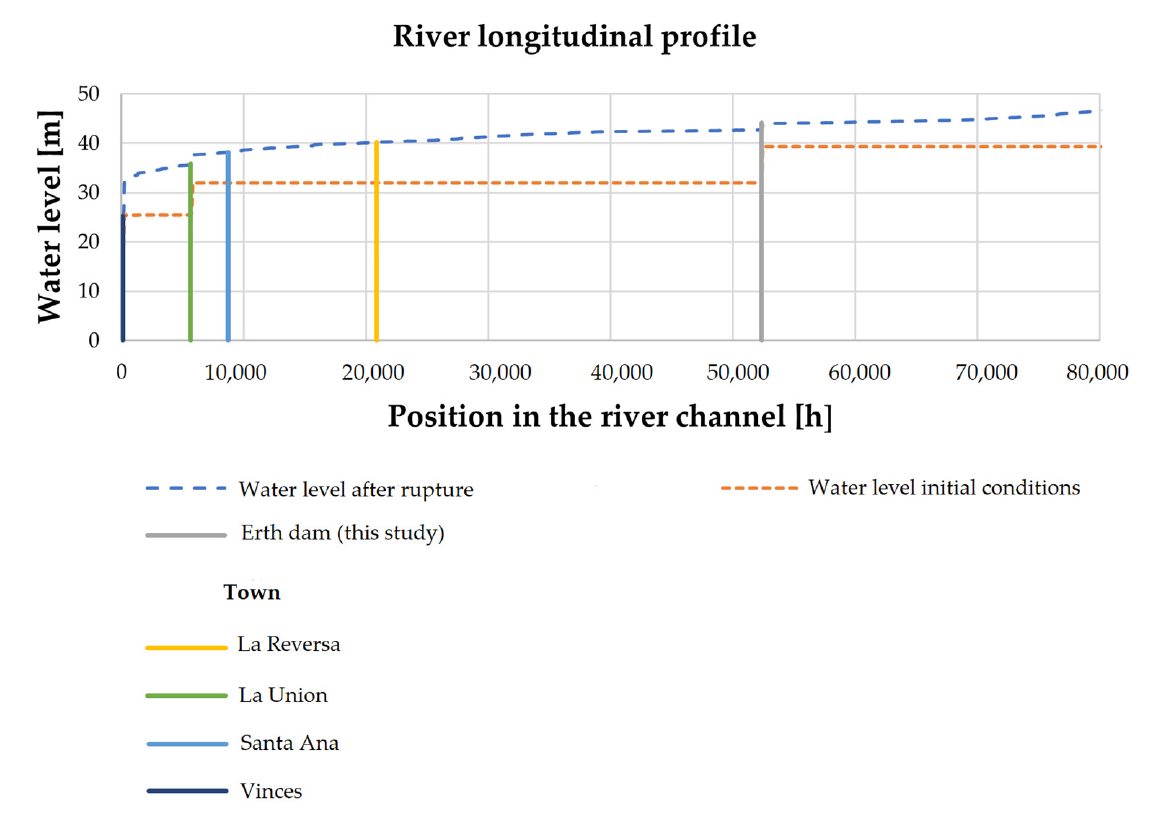
Figure 11. Longitudinal profile of the dam failure.